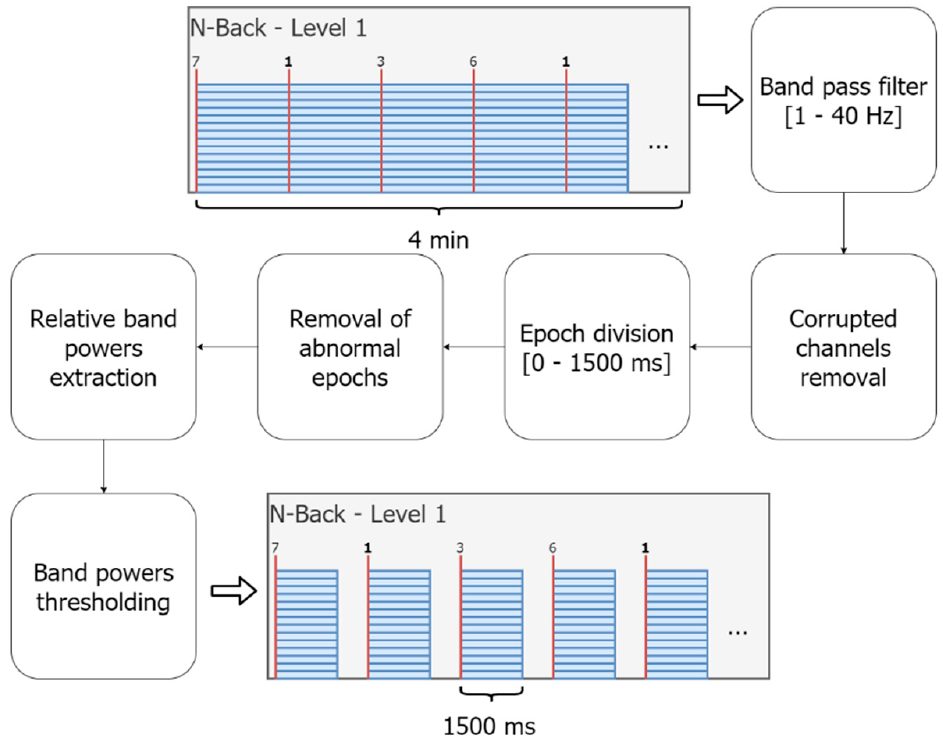
Figure 4. The continuous EEG data were preprocessed (band pass filtered at 1–40 Hz, channel rejection) and split into event-related epochs of 1500 ms each. After epoch rejection, powers of the individual frequency bands (delta-beta) were